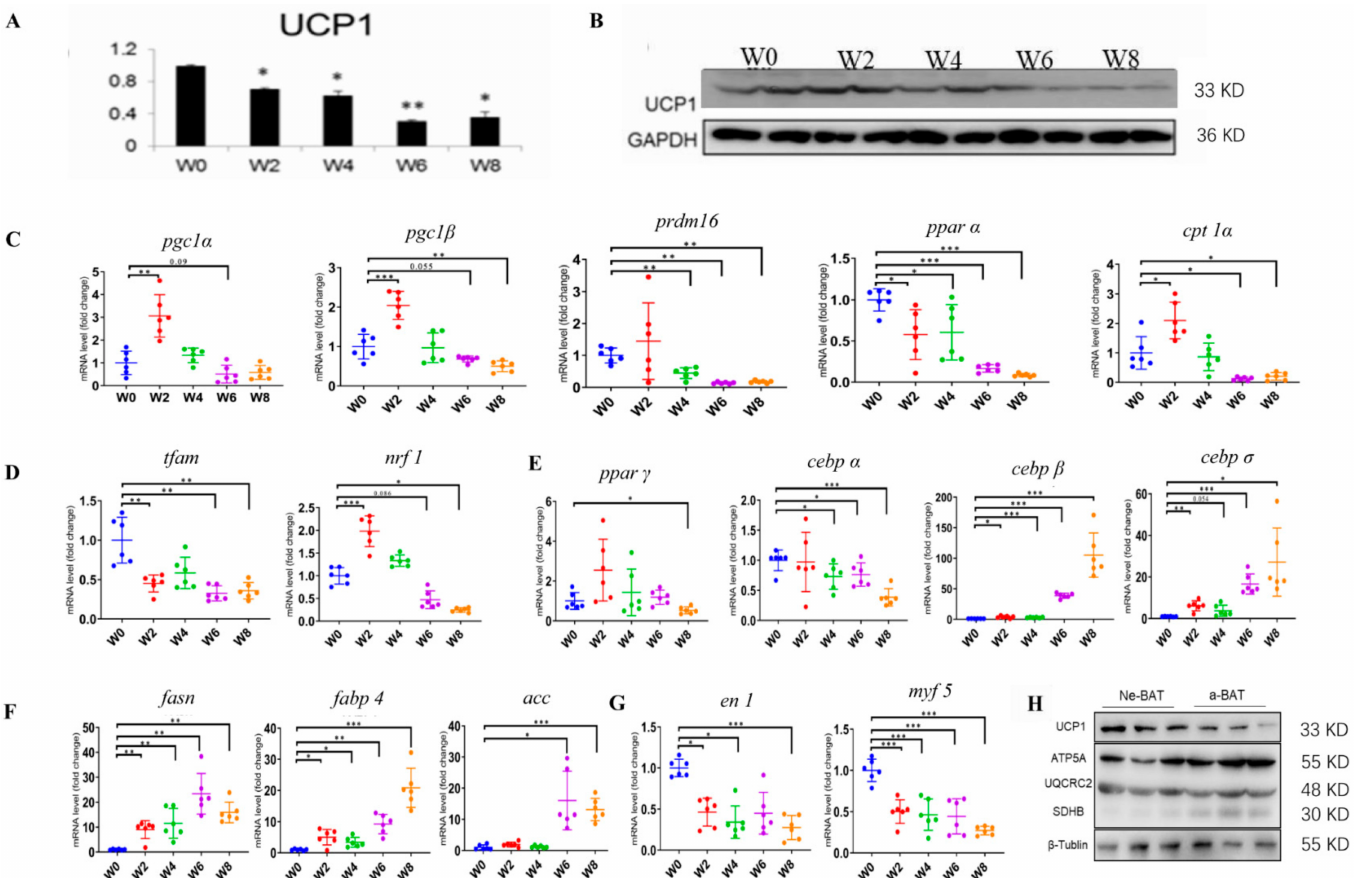
Figure 2. The molecular dynamic changes in BATs during development post-pregnancy. ( A ) mRNA and ( B ) protein expression levels of ucp1 , ( C ) mRNA expression levels of other thermogenic genes ( pgc1 α , pgc1 β , prdm16 , ppar α , and cpt1 α ), ( D ) mitochondrial genes ( tfam , nrf1 ), ( E ) brown adipogenic synthesis ( ppar γ and cebp α ), and adipocyte di ff erentiation genes ( cebp β and cebp δ ), ( F ) lipid synthesis genes ( fasn , fabp4 , and acc ), and ( G ) brown adipocyte progenitor markers ( myf5 and en1 ). ( H ) Protein expression levels of ucp1 and oxphos ( atp5a , uqcrc2 , and sdhb ). Data are presented as the mean ± sem. n = 6 per group. The significance of the di ff erence was set at * p < 0.05, ** p < 0.01 and *** p < 0.001 relative to